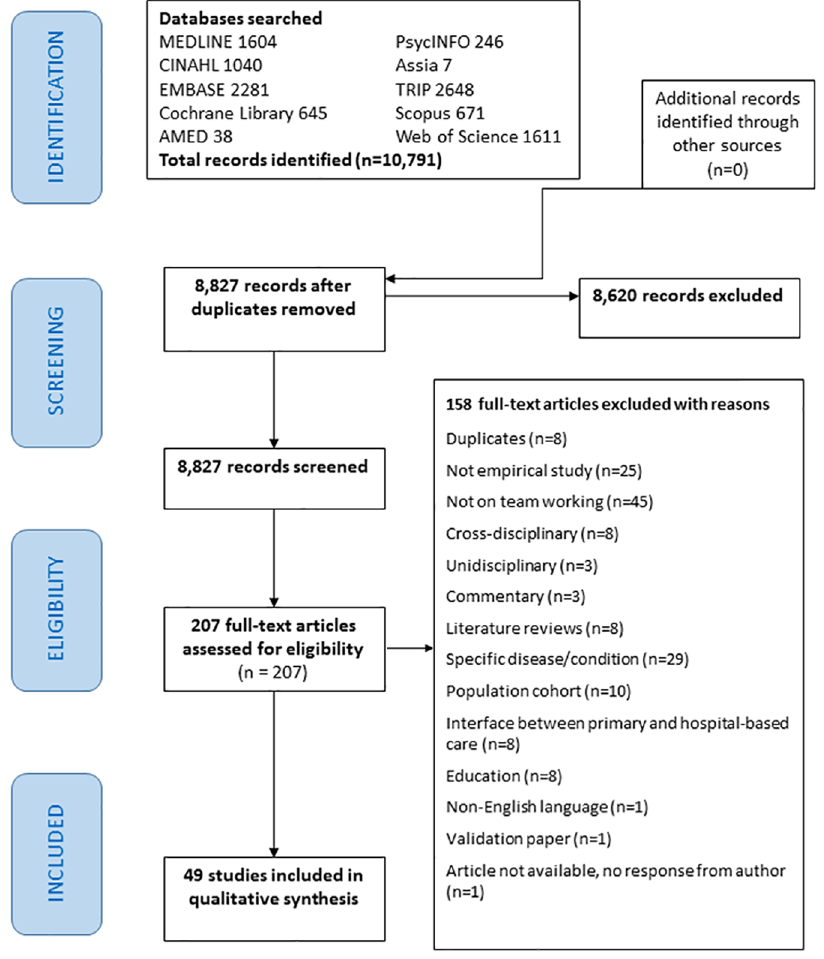
Fig 1. PRISMA flow diagram